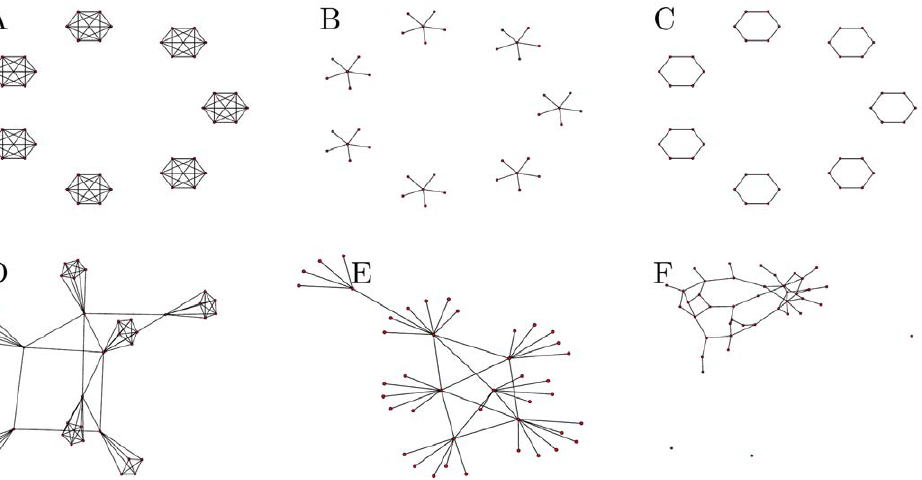
Figure 3. Graphs illustrating the 6 network designs. Cliques (A), Stars (B), Cycles (C), Connected Cliques (D), Connected Stars (E), and Erdos- Renyi ‘‘ER’’ (F). Each design is configured by just one or two parameters (the number of individuals per cell and/or the random connectivity). This enables rapid solution of the optimization problem. In computations the networks were larger ( n ~ 180 nodes).